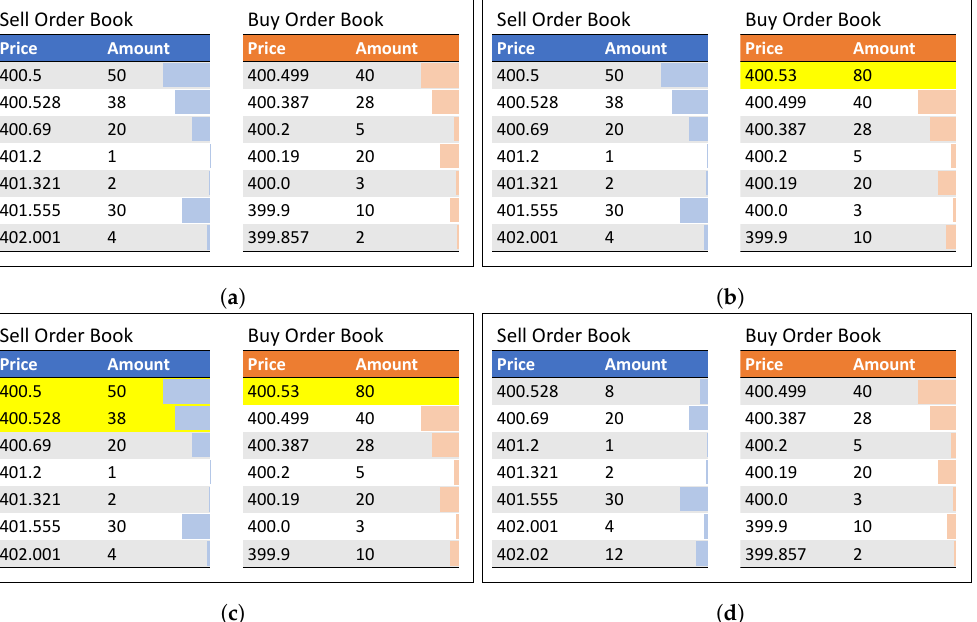
Figure 2. Continuous double auction mechanism for setting the market price. ( a ) Before inputting a new order. ( b ) Inputting 80 buy orders at 400.53 (highlighted in yellow). ( c ) Contracting 50 orders at 400.5 and 30 orders at 400.528 (highlighted in yellow). ( d ) After